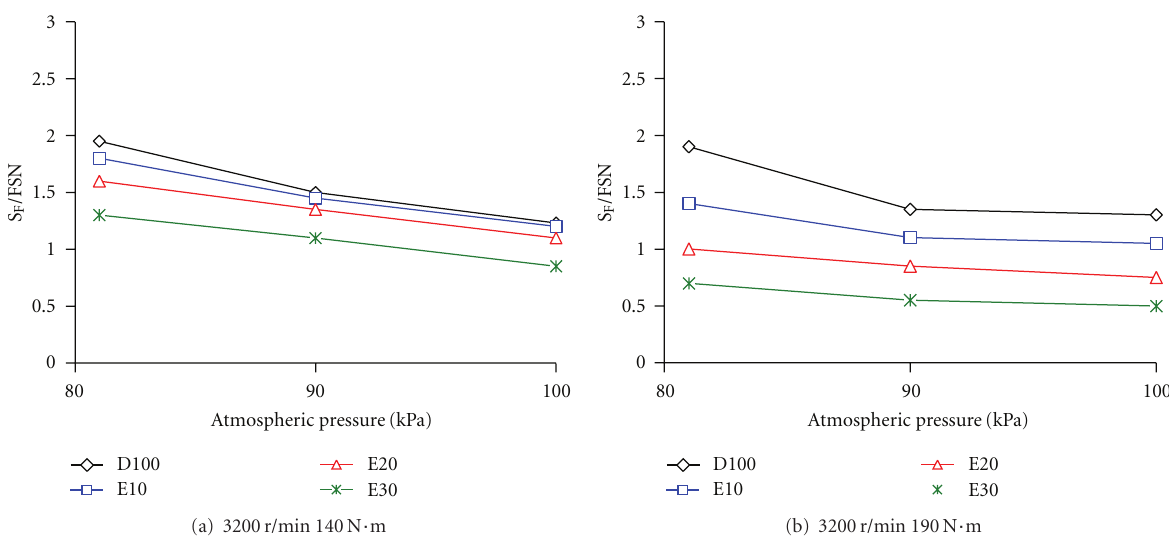
Figure 13: Comparison of smoke of di ff erent atmospheric pressure and mix proportion at speed 3200